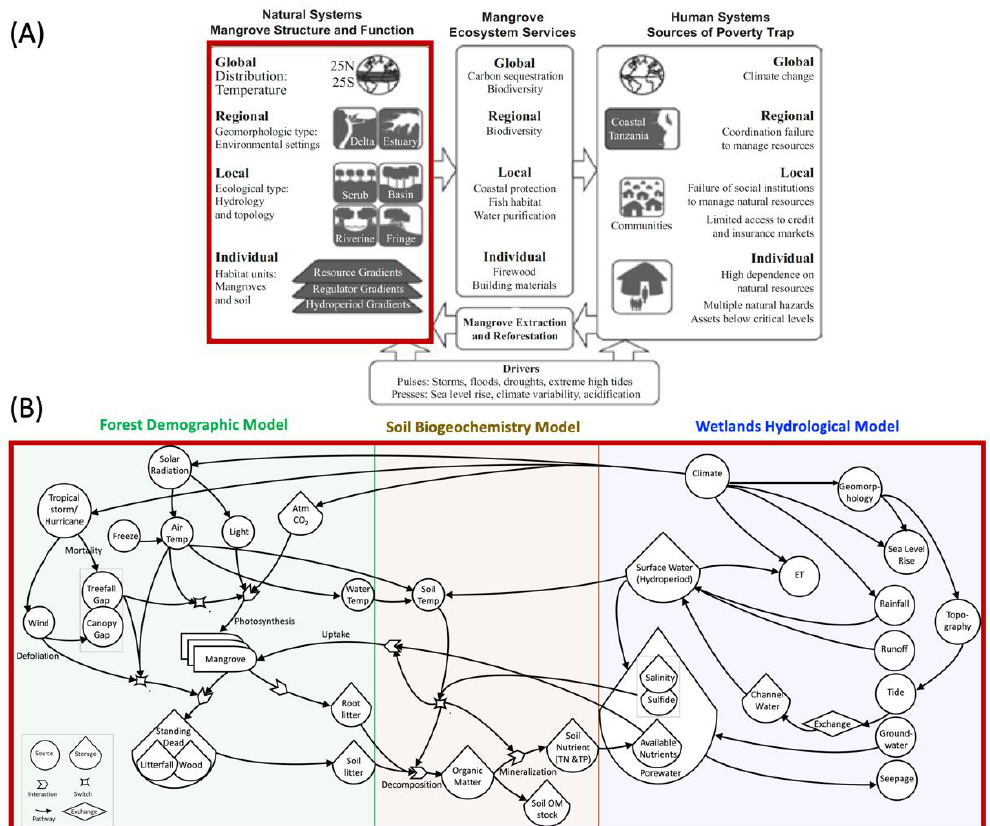
Figure 5. A coupled natural – human system where mangrove ecosystem services (ESs) are critical in countries where poverty is high in coastal communities (e.g., Tanzania; [32]). ( A ) Connectivity among different processes at global, regional, local, and individual scales in socioecological systems highlighting the functional role of mangrove ESs. ( B ) Conceptual model of the natural system as an idealized mangrove modeling tool. This scheme includes three main sub-models (multi-model approach): forest demographic, soil biogeochemistry, and hydrological models; these modules are dynamically coupled to simulate the mangrove forest structural and functional variations under different natural disturbances (e.g., sea-level rise and tropical cyclones) regimes and human activities (e.g., defoliation and freshwater restoration).